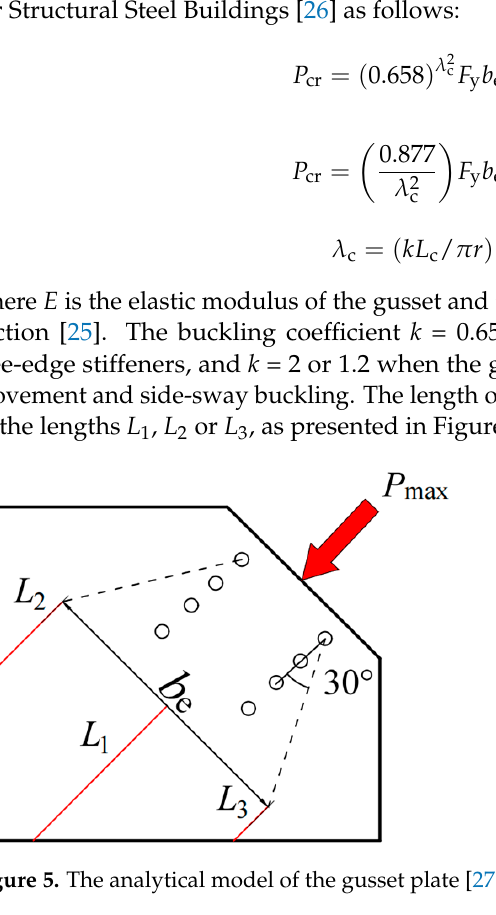
maximum design drift of the bridge; d p is the square bolt